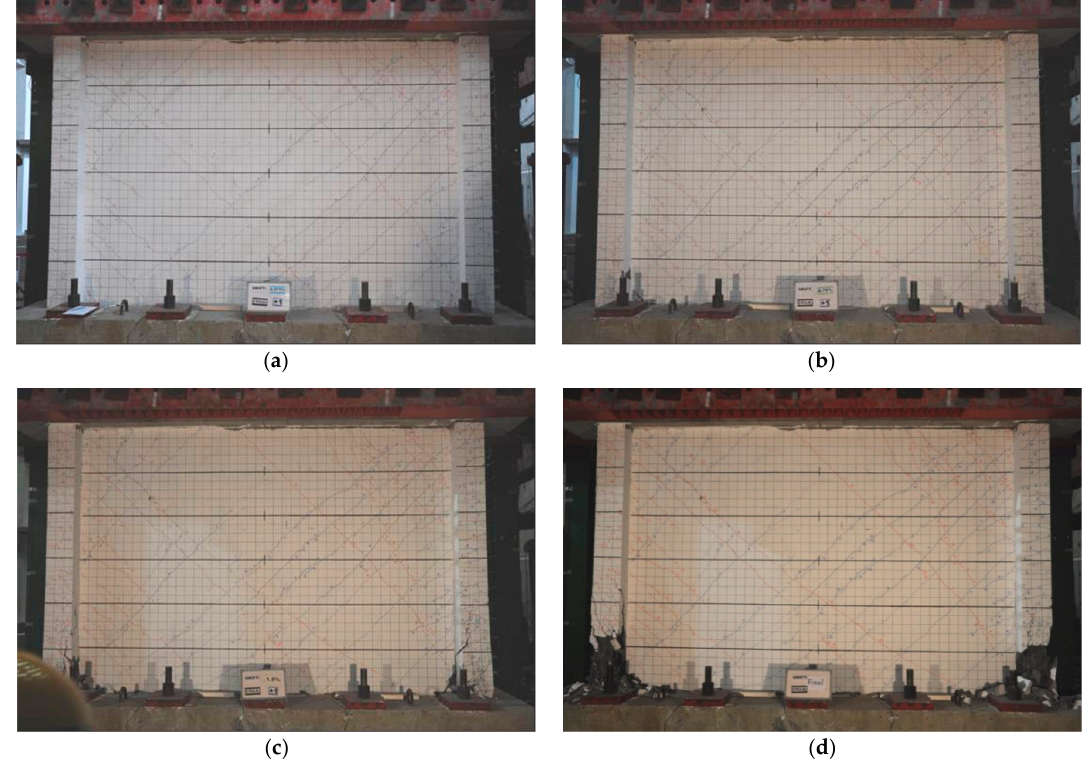
Figure 9. Failure mode of the specimen RCW1. Cracking patterns of the specimen RCW1 at ( a ) drift 0.25%, ( b ) drift 0.5%, ( c ) drift 0.75% and ( d ) final failure mode at drift 1.0%.